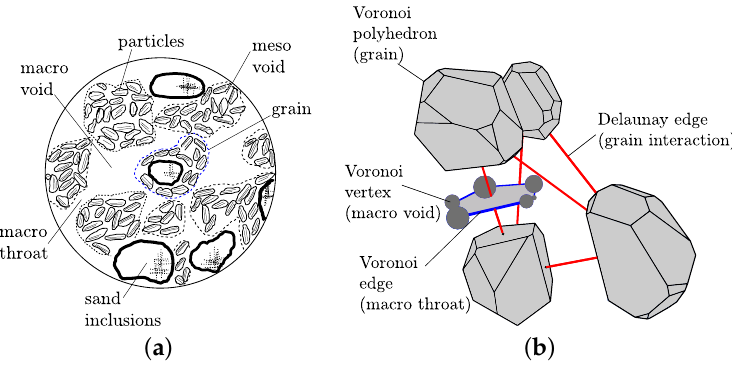
Figure 1. Bentonite fabric: ( a ) macro-scale of heavily-compacted unsaturated bentonite (adapted from [1]) and ( b ) schematic presentation of four Voronoi polyhedra and the corresponding Delaunay tetrahedron. The spheres and pipes corresponding to a Voronoi polyhedron face are also presented. The Voronoi grains are scaled down to improve the clarity of the presentation (in the actual network, the grains are in